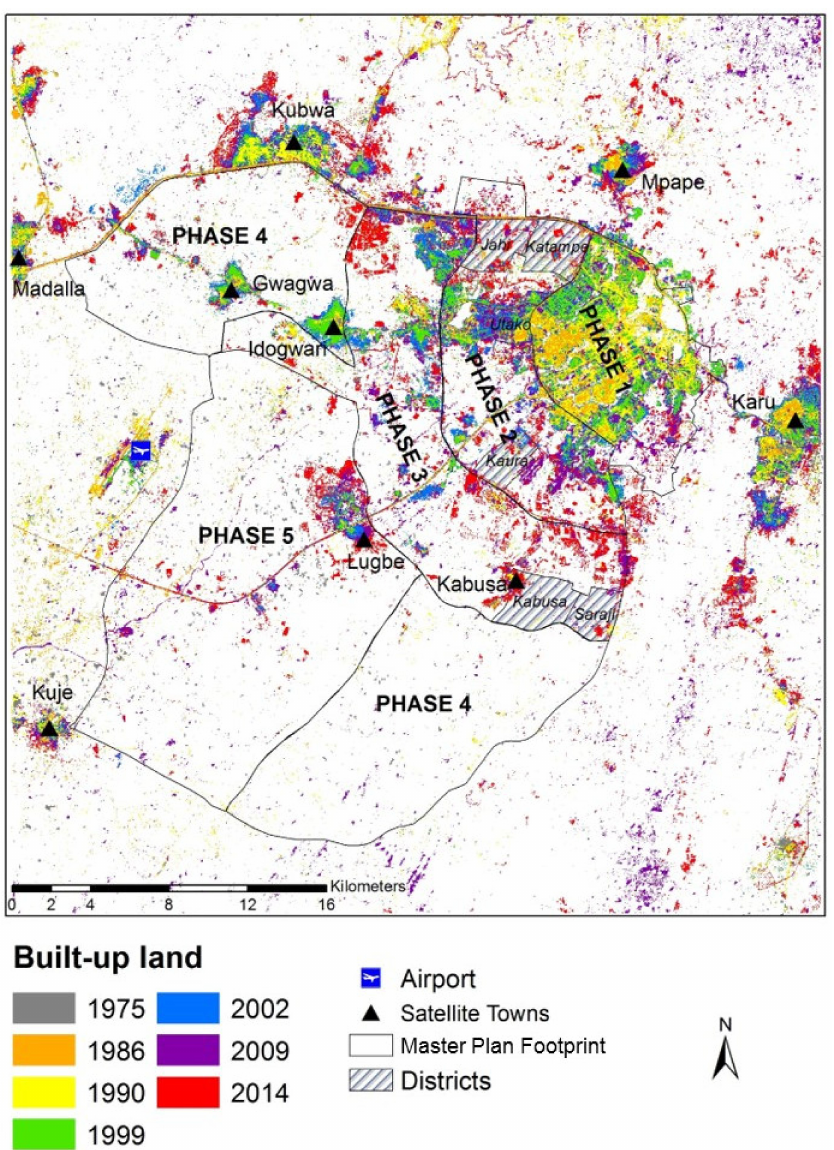
Figure 4. Development of built-up land in the Abuja area between 1975 and 2014. Districts refers to the individual districts of Jahi, Katampe, Kaura and Utako in the Master Plan Development Phase 2 and Kabusa and Saraji in Phase